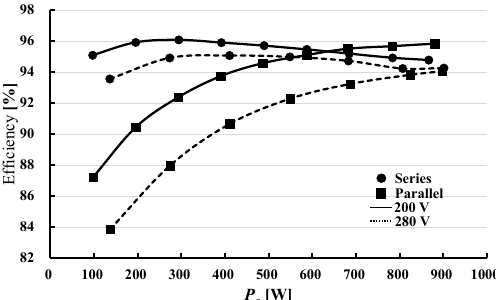
Figure 21. Efficiency characteristics for output power.